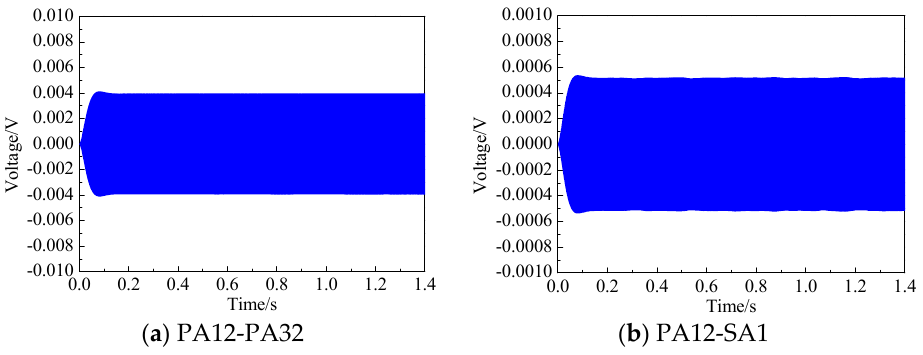
Figure 6. Voltage response of PA32 and SA1 under the excitation of PA12 on Side A.